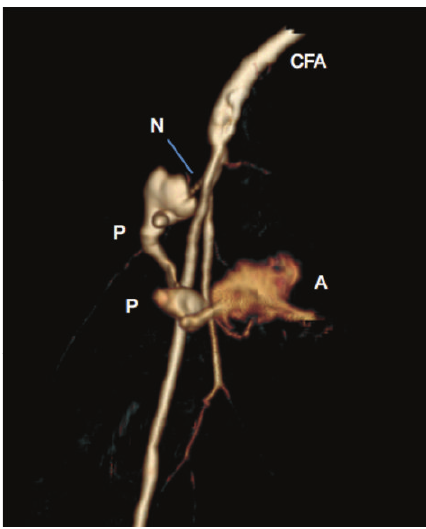
Figure 3: 3D view computed tomography angiography image of the right groin: large pseudoaneurysm (P) communicating with the right superficial femoral artery through a pseudoaneurysm neck (N). Femoral common artery (CFA). Active bleeding